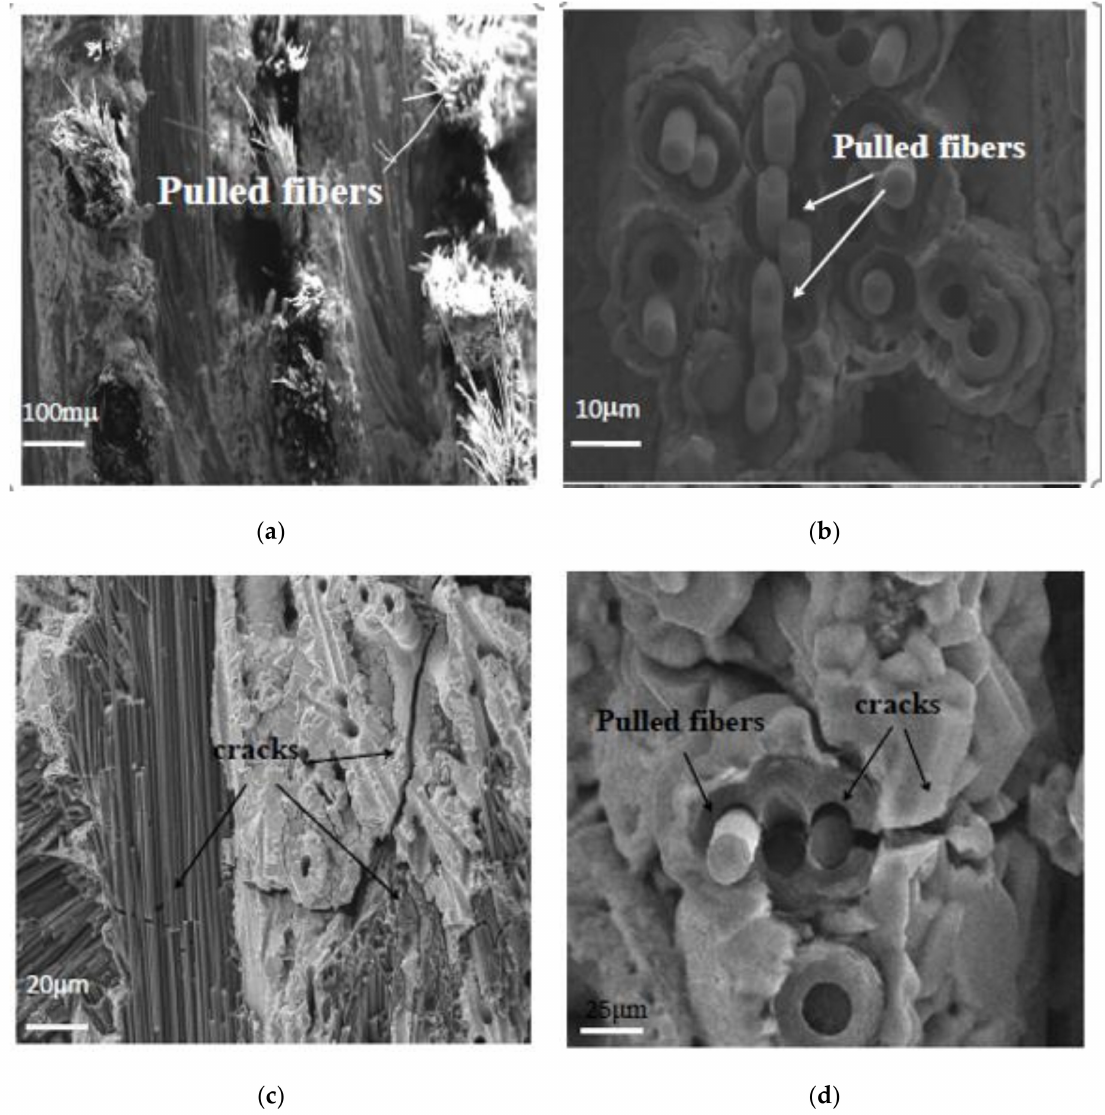
Figure 6. SEM photographs of the fracture surfaces of the Cf / C-TiC composite. ( a , b ) Carbon fibers pulling-out, and ( c , d ) crack propagation and deflection in Cf / C-TiC